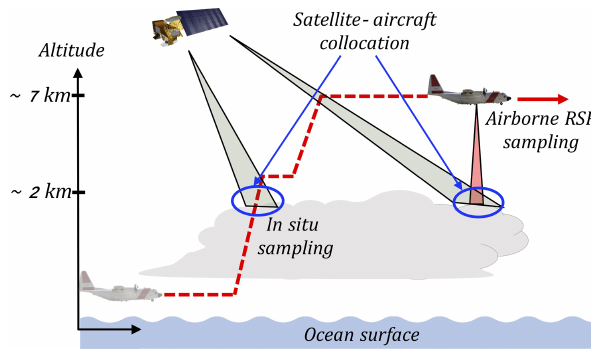
Figure 2. Collocation method between satellite and airborne in situ (CDP probe) and RSP observations. Satellite pixels are paired with in situ samples collected during profiling maneuver, whereas satel- lite and RSP data are collocated for high-altitude aircraft transects ( ∼